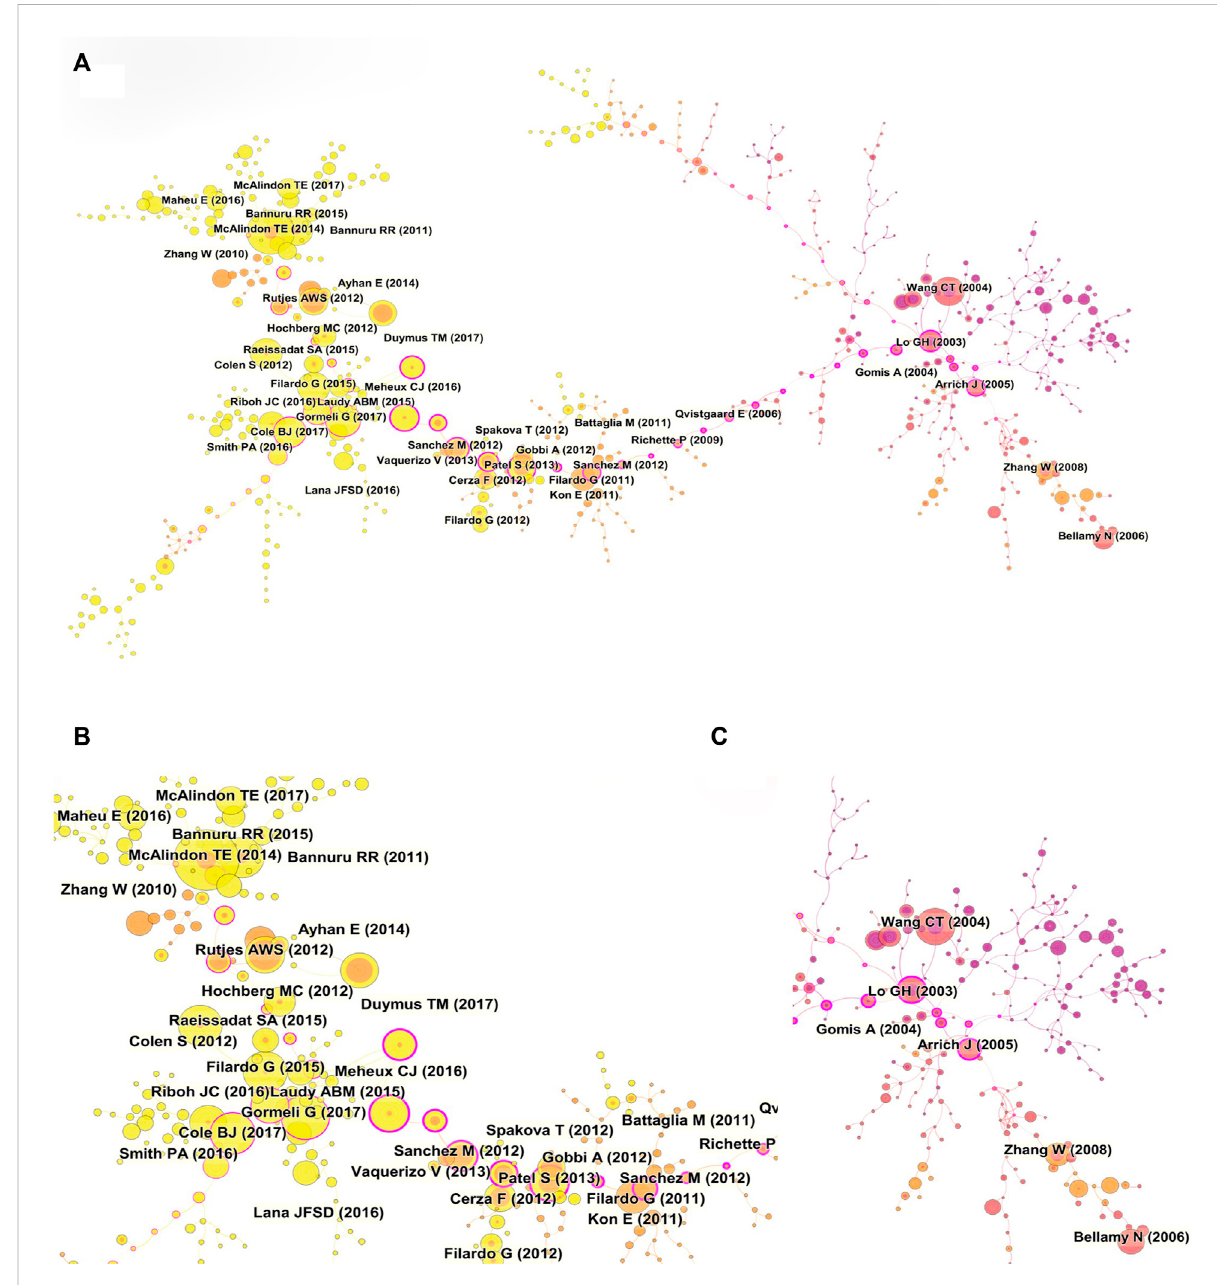
FIGURE 8 (A) Visualization map of co-cited references analysis based on CiteSpace. (B , C) The partial enlarged drawings of panel